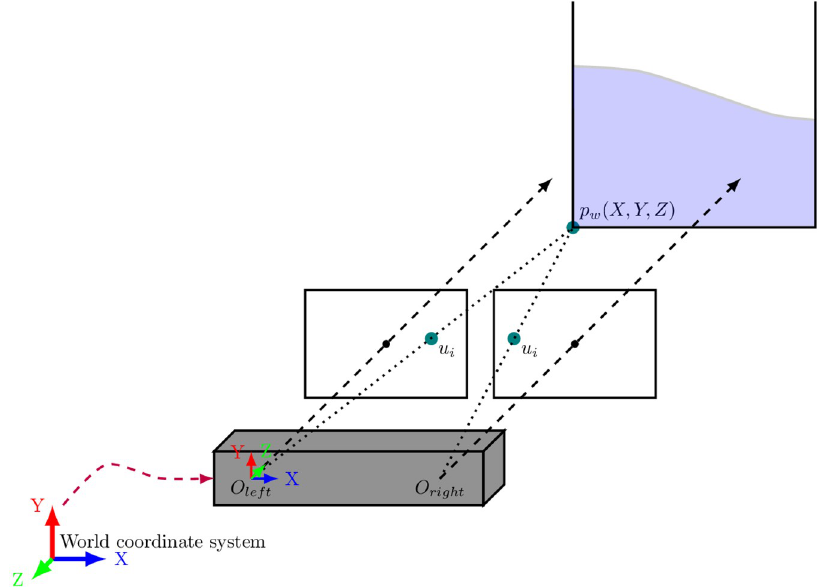
Fig 9. The picture shows the functioning of the stereo system. The camera moves freely, and its movement is related to the origin position through the extrinsic parameters. In computer vision, at least two images are required for the 3D reconstruction of a point. The camera performs continuous triangulations so as to export the depth of each pixel relating the 2D matches detected among right and left lenses.